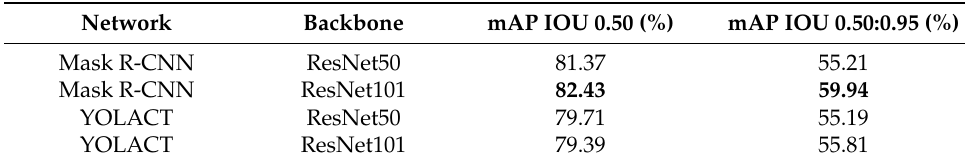
Table 10. Comparison with other architectures.